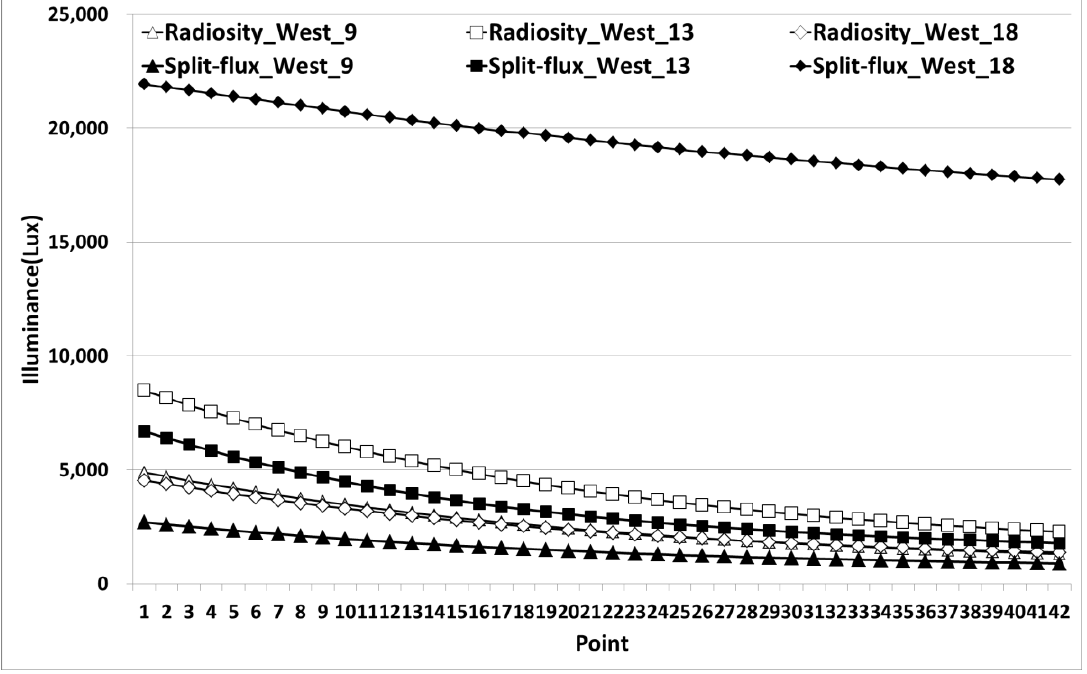
Figure 2. Interior illuminance at 42 reference points at 09:00, 13:00 and 18:00 for West orientation of